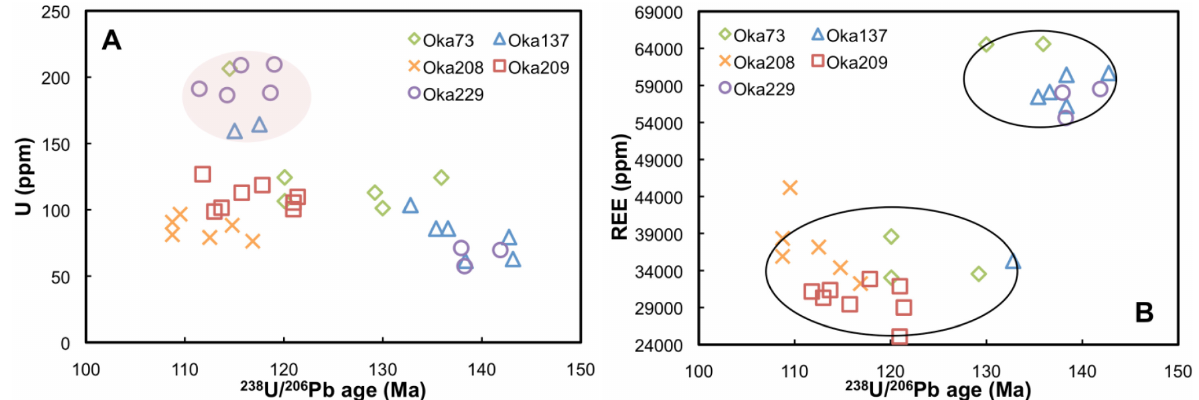
Figure 13. ( A ) Plots illustrating the chemical and geochronological data for perovskite: